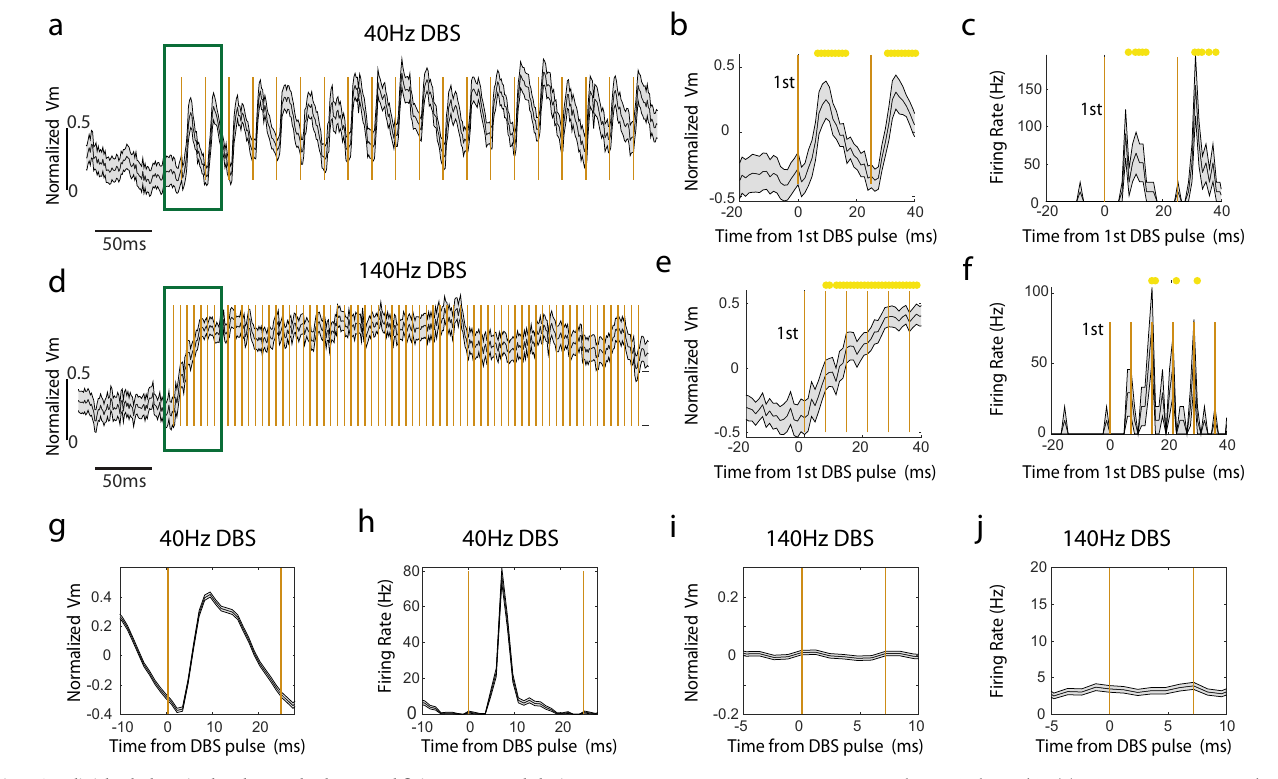
area represents SEM. Time window as indicated in ( a ). Time zero corresponds to the fi rstDBSpulsetime.YellowdotsrepresentVmmodulationsduringDBSthatare two standard deviations from the baseline Vm distribution. c Same as ( b ), but showing the population-averaged fi ring rate. d – f Same as( a - c ),but for 140Hz DBS ( n =26 neurons). g Population-averaged Vm aligned to the onset of all pulses during 40Hzstimulation. Golden lines indicate the pulse onsettimes. Shaded area represents SEM. h Same as ( g ), but for fi ring rate. i - j Same as ( g , h ), but for 140Hz